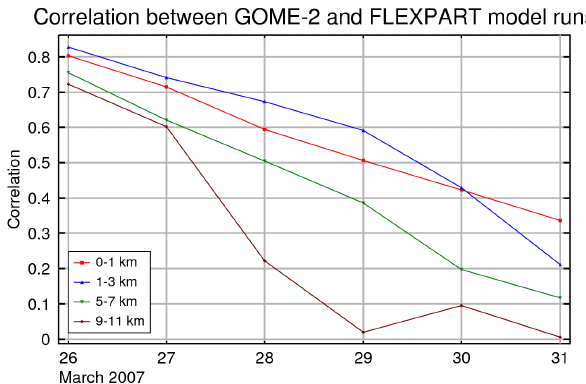
Fig. 6. Spatial correlation between GOME-2 BrO data and FLEX- PART model runs compared for different initialisation heights. All data North of 60 ◦ was